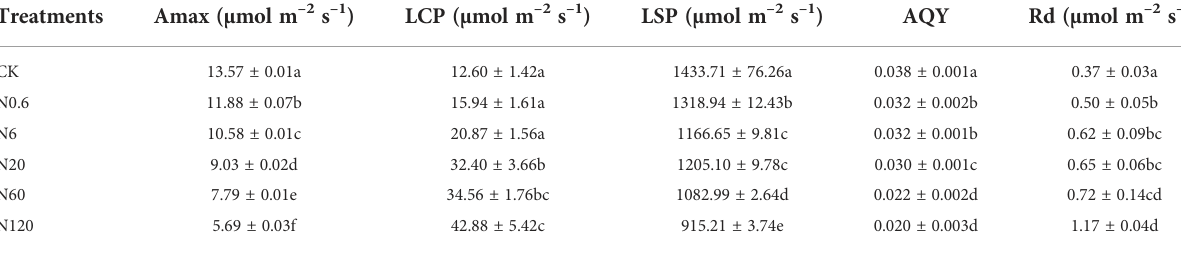
TABLE 3 Effects of nicosulfuron on the P n -PAR curve parameters of sugar beet leaf. Treatments